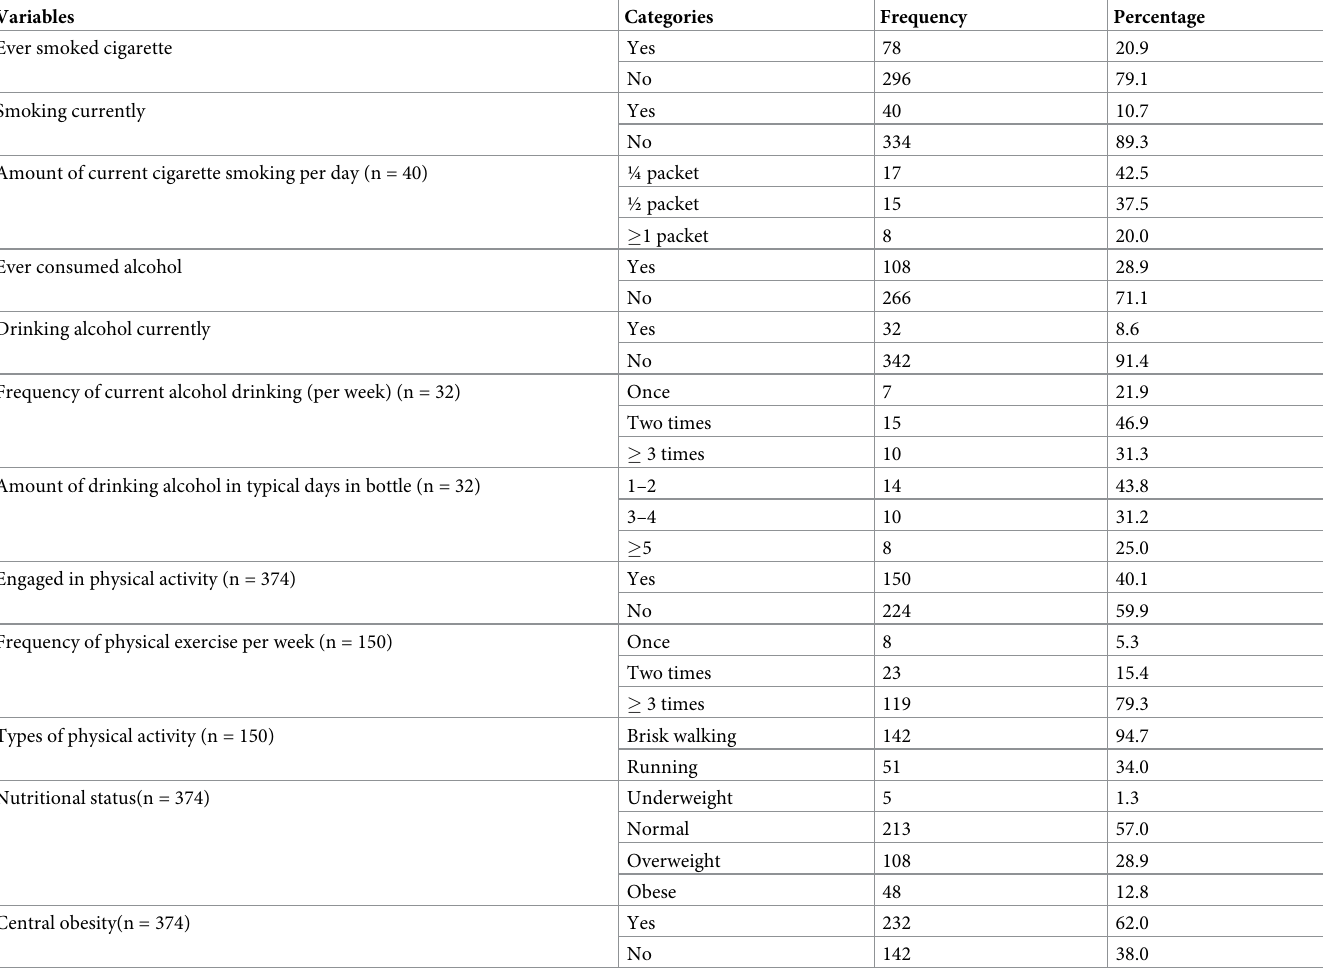
Table 2. Lifestyle characteristicsofT2DM patients attending public hospitals in Harari region, Eastern Ethiopia, February to March2019 (n =